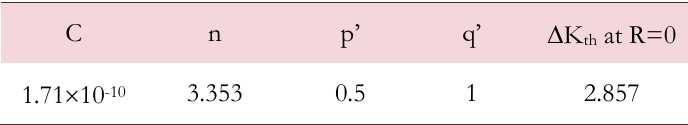
Table 3: Parameters of fatigue crack growth according to Nasgro equation.